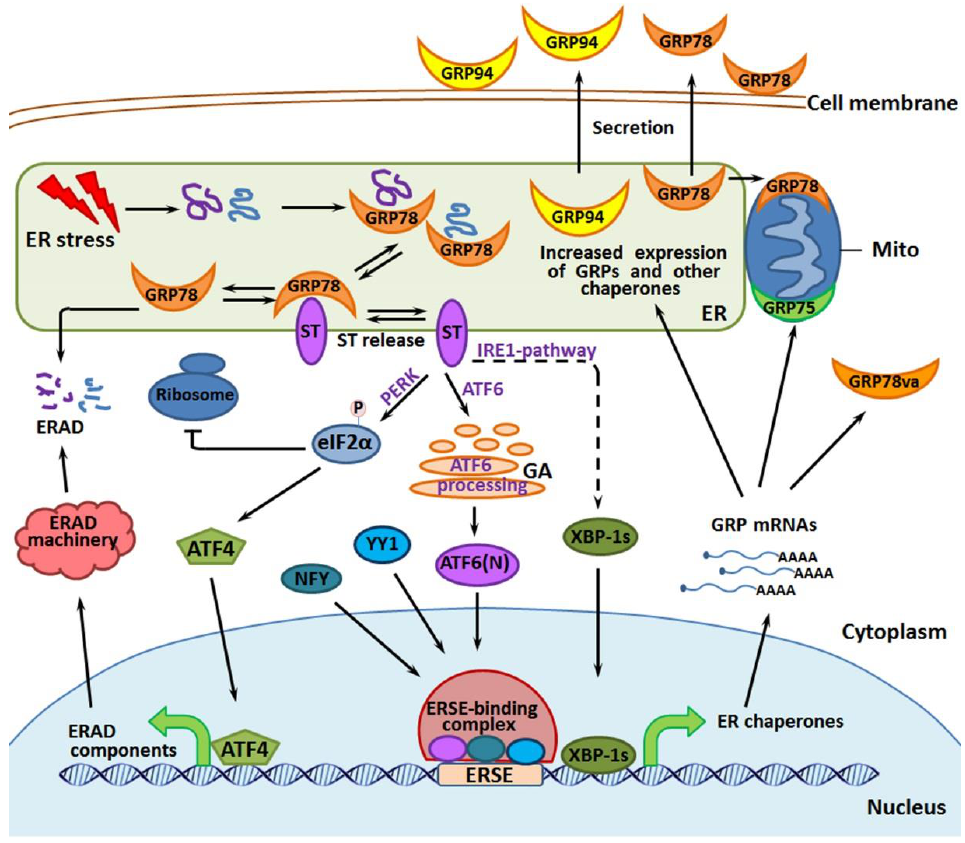
Figure 4. A simplified scheme showing the endoplasmic reticulum (ER) stress response: GRP78 residing within the ER lumen is bound to ER-specific stress transducers (STs) to maintain them in the inactive state. In the case of ER stress, GRP78 is recruited by stress-damaged (misfolded) proteins, which is accompanied by the release of three STs, namely protein kinase RNA-like endoplasmic reticulum kinase (PERK), activating transcription factor 6 (ATF6), and inositol-requiring enzyme 1 (IRE1). These STs are activated and trigger the so-called ‘unfolded protein response’ (UPR) , which stimulates certain signaling pathways, resulting in the arrest of translation while generating the active form of ATP4. In the nucleus, active ATP4 initiates the expression of genes whose products are components of the ER-associated protein degradation (ERAD) machinery aimed at the disintegration